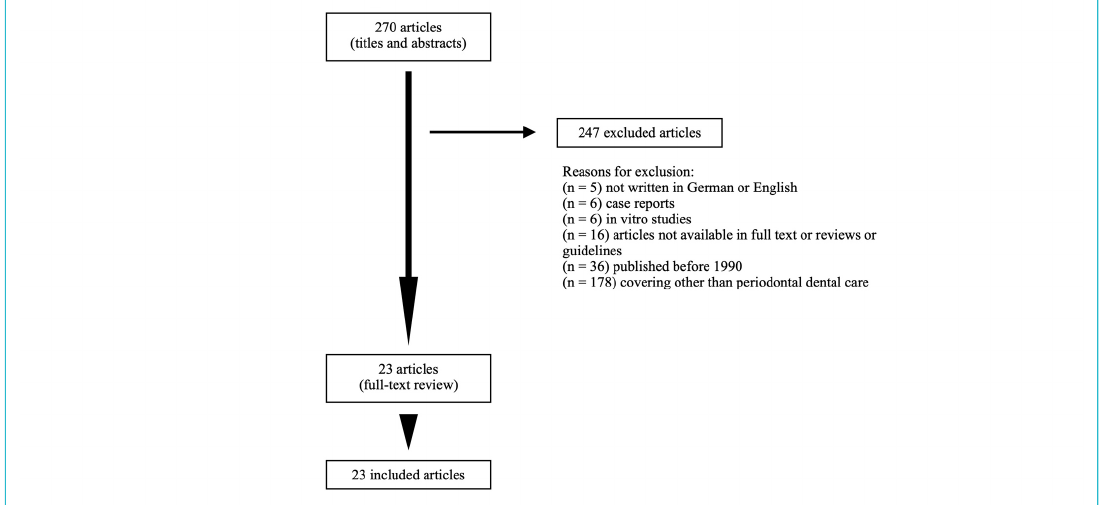
Figure 1: Selection of the studies: number of screened, included and excluded studies.